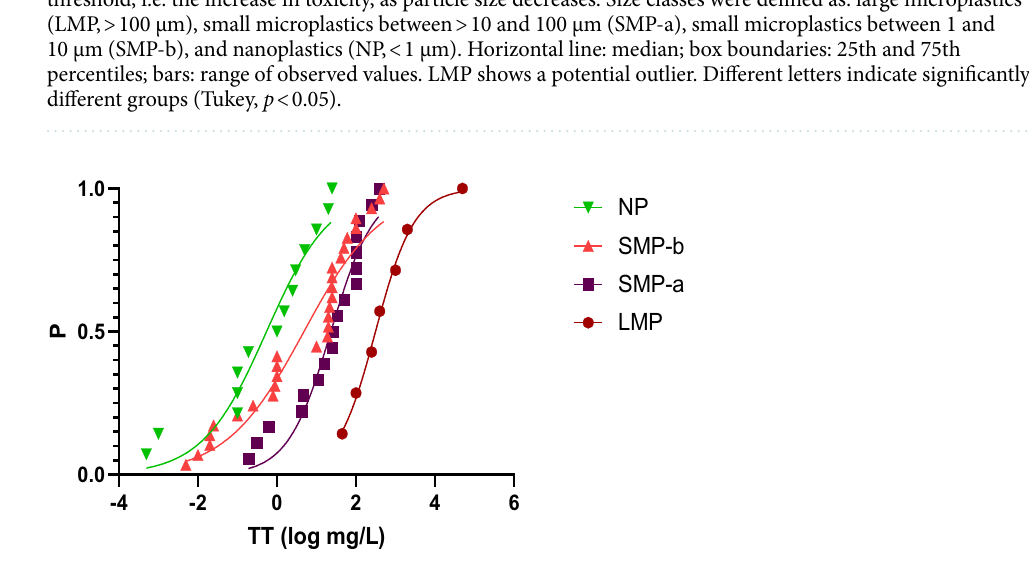
Figure 3. Species sensitivity distribution (SSD) curves fit to the four plastic-size classes, defined as in Fig. 2. Notice lower toxicity thresholds (TT), i.e. higher toxicity, as particle size decreases.